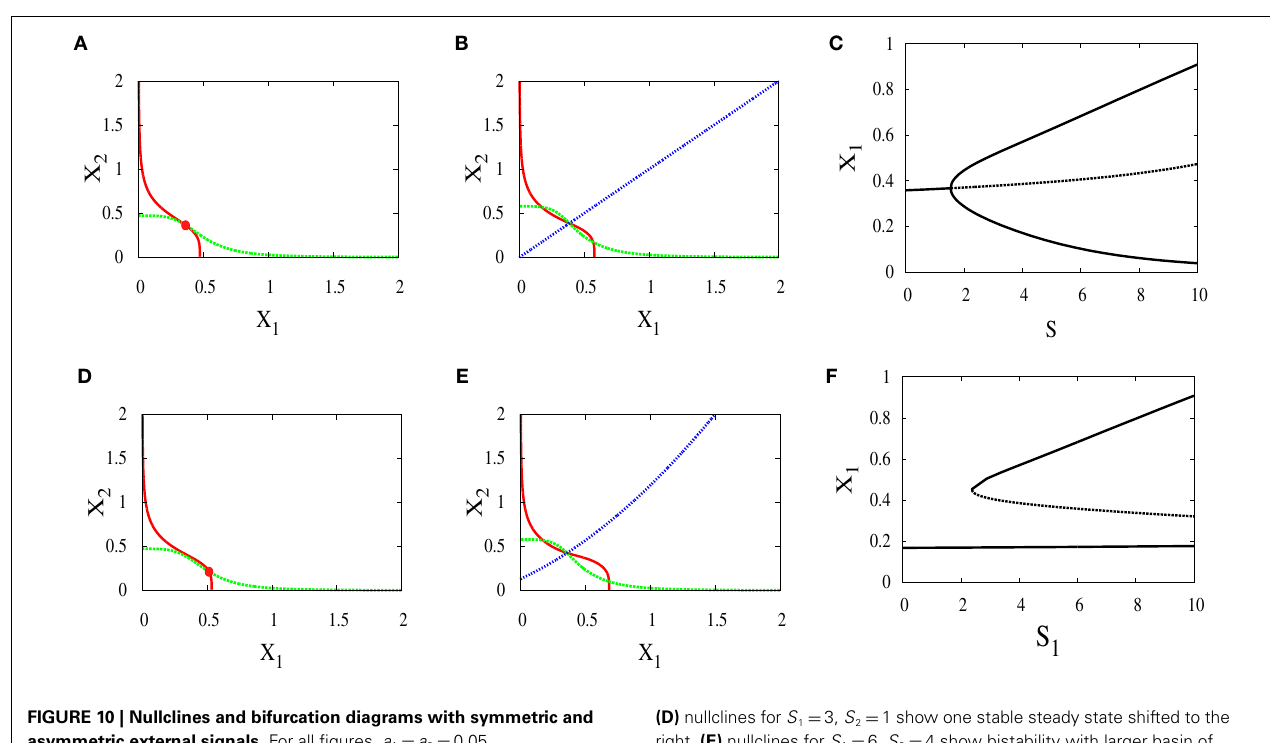
FIGURE 10 | Nullclines and bifurcation diagrams with symmetric and asymmetric external signals . For all figures, a 1 = a 2 = 0.05, b 1 = b 2 = 0.45, r = 0.5, k 1 = k 2 = 1, n = 4. (A) Nullclines for S 1 = S 2 = 1 show one stable steady state, (B) nullclines for S 1 = S 2 = 4 show bistability, (C) near-symmetric supercritical pitchfork bifurcation,